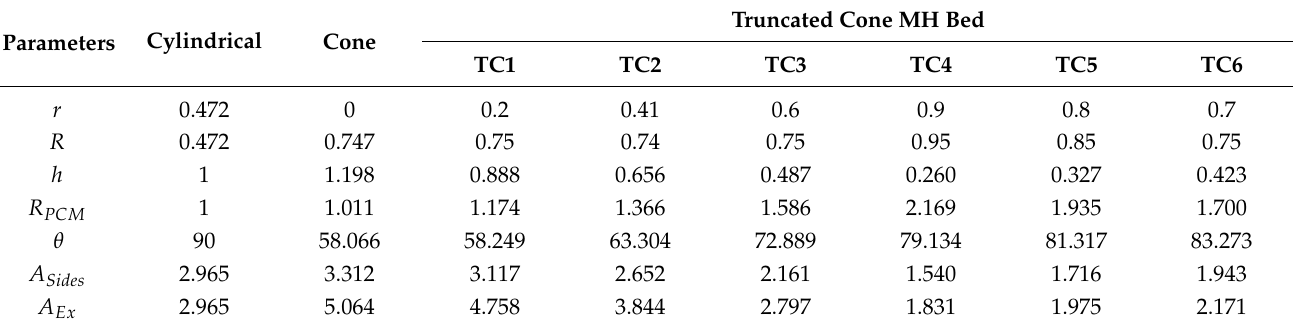
Table 3. The geometric parameters of the MH-PCM disk for different